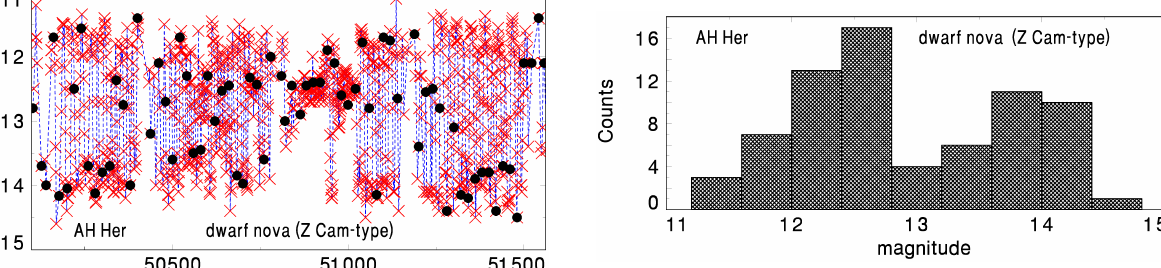
Figure 3: Statistical distribution of the approximated sampled Gaia data of the dwarf nova AH Her (from Fig. 1). Notice that the histogram is not